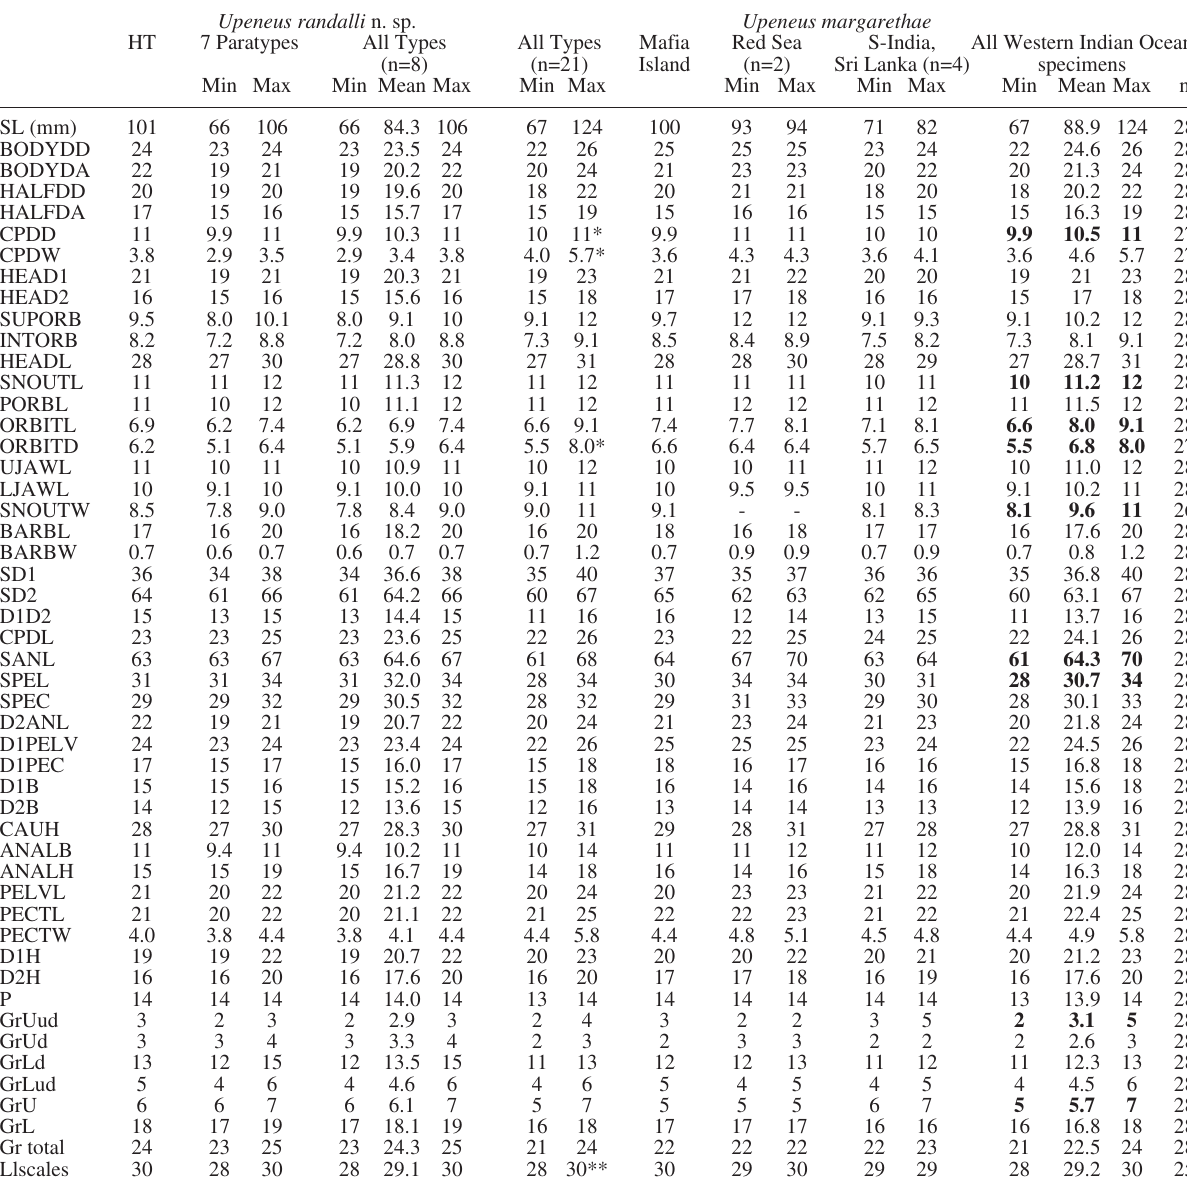
Table 2. – Measurements (in % SL) and counts for Upeneus randalli n. sp. and U. margarethae of the Western Indian Ocean. Characters showing deviations from Uiblein and Heemstra (2010) are indicated in bold. Upeneus randalli n.